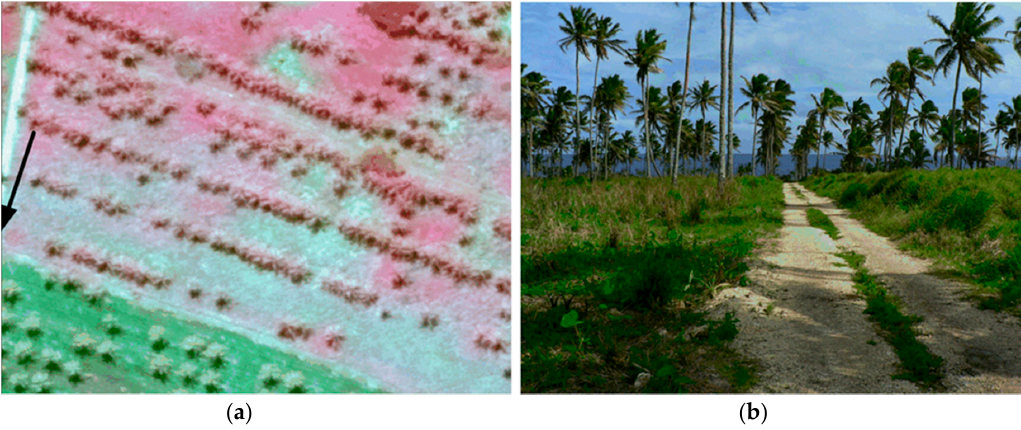
Figure 5. Example of satellite data showing coconut trees ( a ) with the associated Google Earth geo-tagged ground photo and ( b ) (black arrow shows direction of view in the geotagged photo).